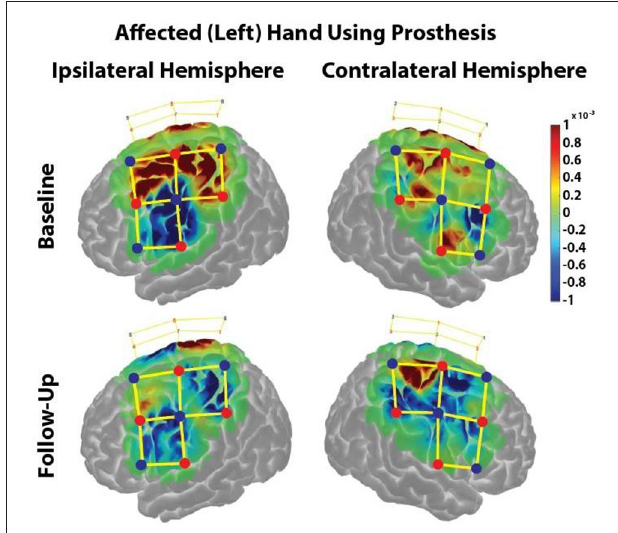
FIGURE 4 | HbO responses during the Box & Block Task using the affected (left) hand before and after the home intervention training. Change in HbO is shown for each channel (yellow lines). An increased HbO response is highlighted in red while a decreased HbO response is highlighted in blue. The change in HbO is centered on zero, where a change in HbO greater than a threshold of p < 0.01 were plotted. The color bar indicates the scale of the concentration change on the logarithmic scale. Red dots are source optodes, and blue dots are detector optodes. Figures were created using